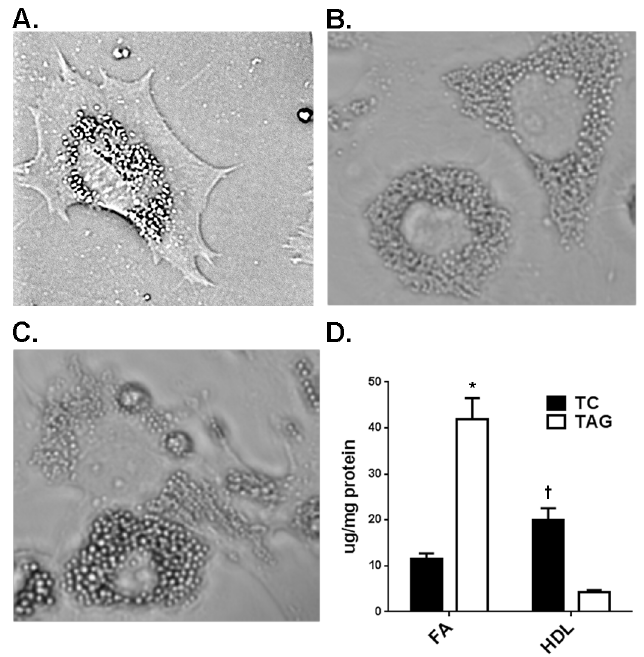
Figure 1. Treatment of cultured granulosa cells with FA or HDL leads to lipid droplet formation. Granulosa cells untreated ( A ) or treated with 240 m M FA ( B ) or 500 m g/ml HDL ( C ) form lipid droplets. C . Quantification of total cellular cholesterol (TC) and TAG in granulosa cells following incubation with either FA or HDL. *, p , 0.001 versus HDL-loaded; { , p , 0.001 versus FA-loaded.